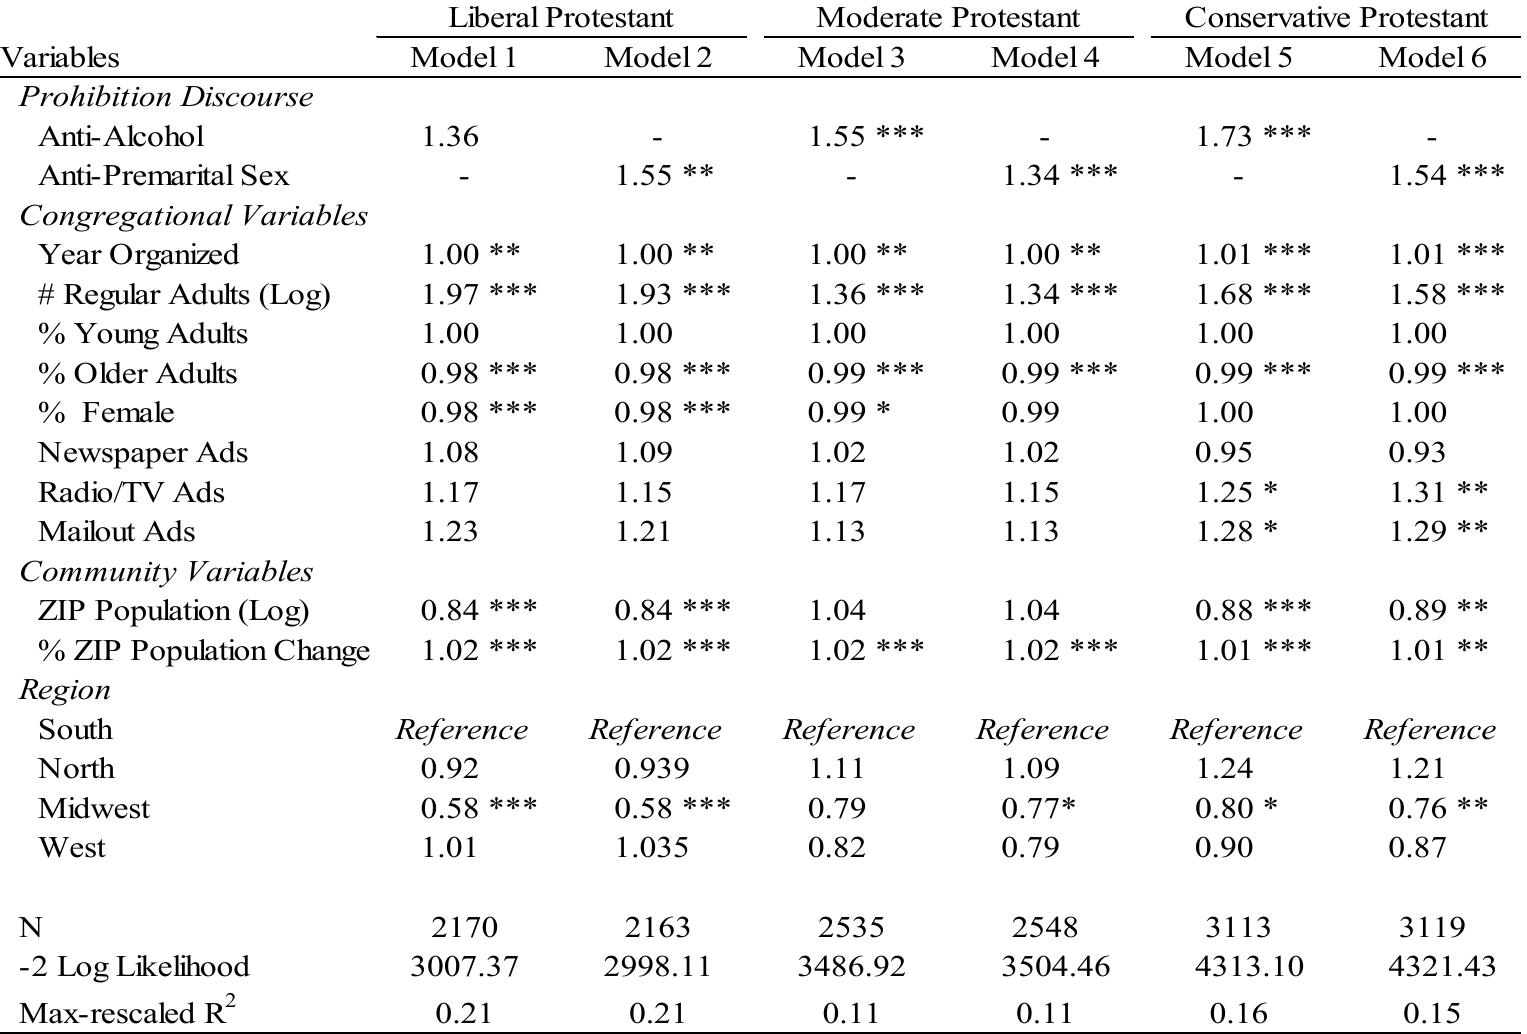
Table 3. Binary Logistic Regressions Predicting Congregations Growing 5% or More (Odds Ratios